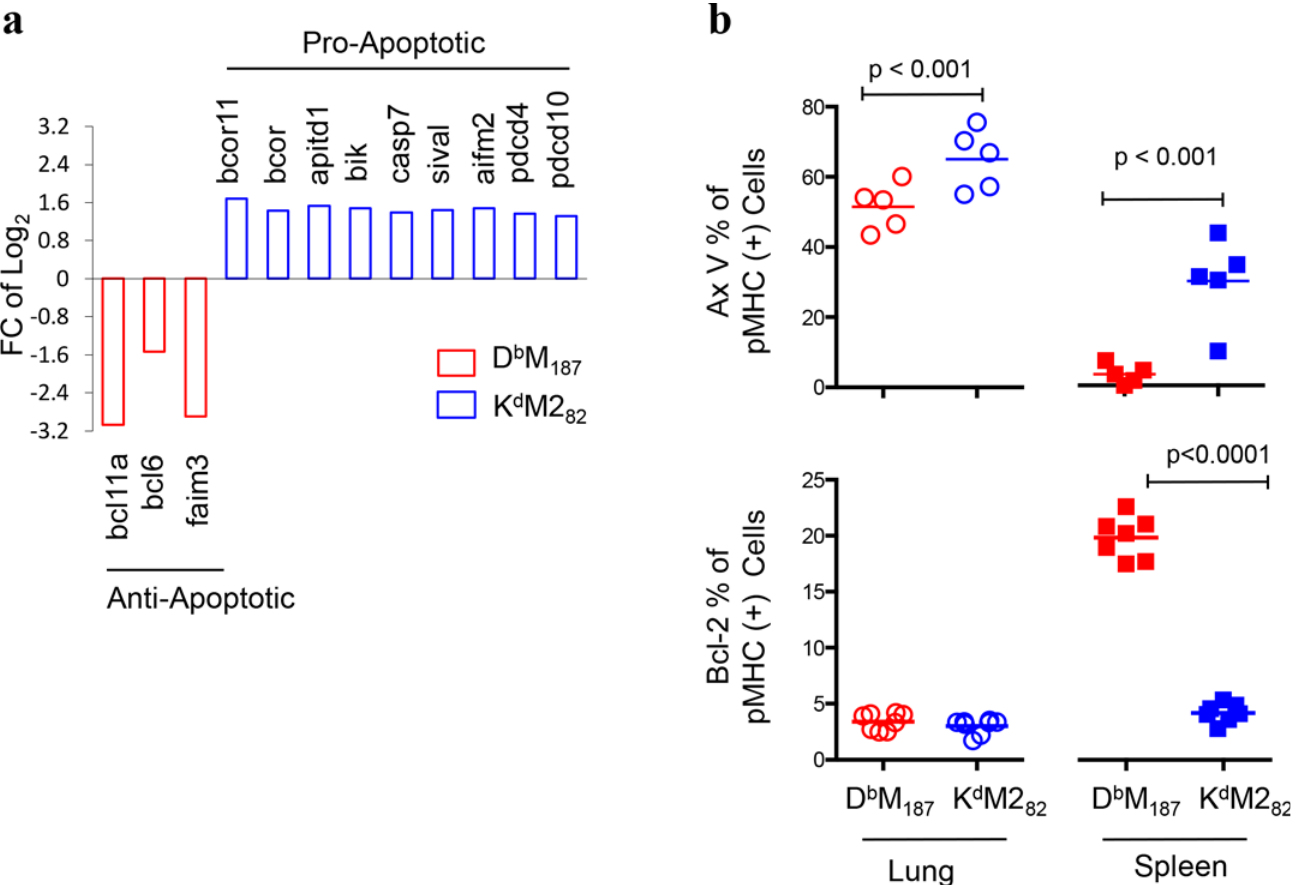
Fig 6. Activated K d M2 82 T cells are apoptotic. (a) Transcriptional expression of genes encoding pro- and anti-apoptosis molecules with FC > ± 1.3, p < 0.05 and FDR < 0.25 were listed. Data were pooled from 10 or 11 individual mice in each group. ( b ) Apoptotic cells were identified by Annexin V staining, and post- transcriptional expression of Bcl-2 was identified by monoclonal antibody with flow cytometry at 7 dpi. The frequencies are shown as mean with independent data point and compared by Student ’ s t -test. Data represent 3 or 4 independent experiments (n = 5/group/experiment). Each symbol represents one mouse.